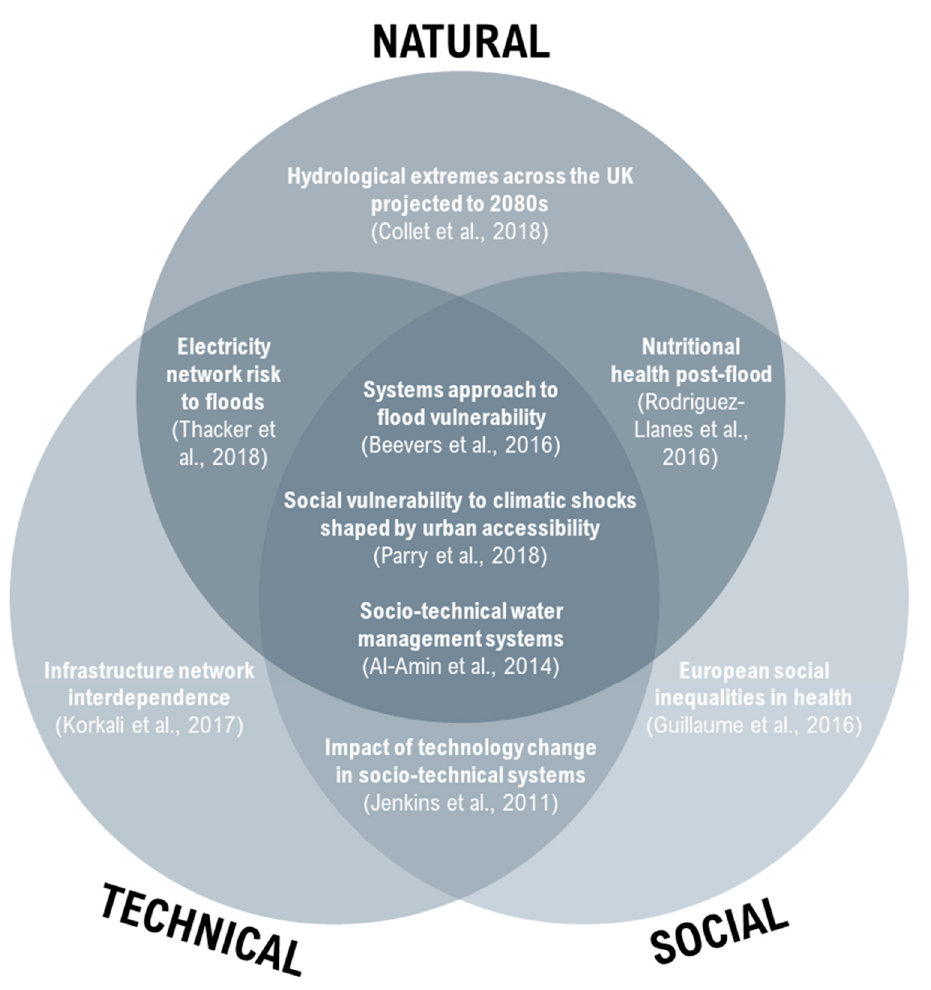
Figure 1. Interacting natural-social-technical subsystems occurring within a catchment [7,10,11,18,24–29].